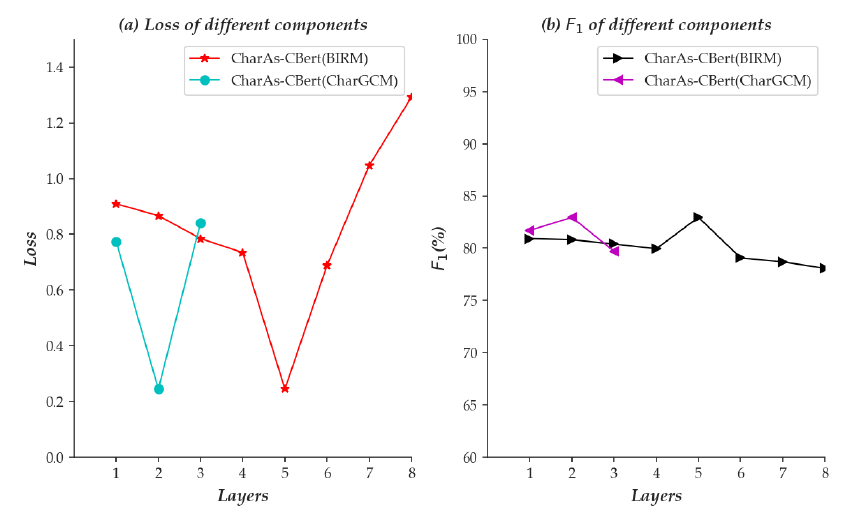
Figure 4. The performance of different layers with BIRM and CharGCM on the Restaurant datasets. ( a ) indicates loss performance; ( b ) indicates F 1 performance of different layers. Loss indicates the loss value of different layers. Layers indicates the number of BIRM and